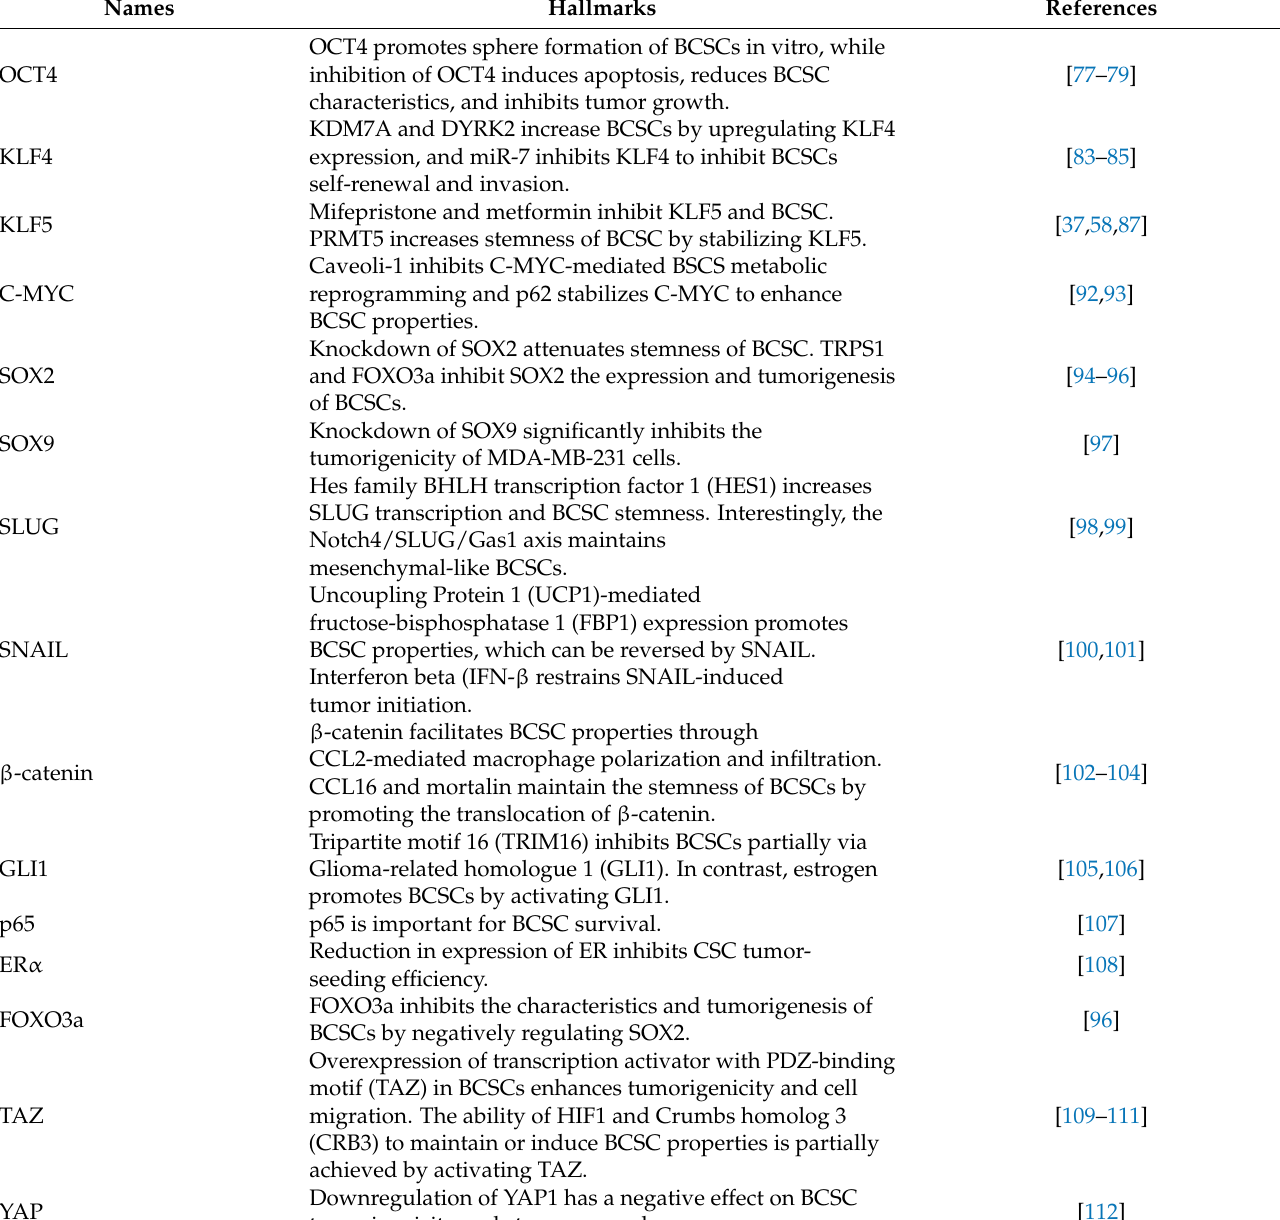
Table 3. Transcription factors and co-activators regulating